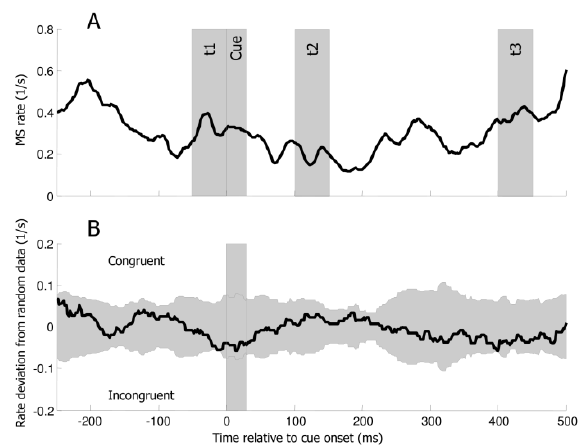
Figure 5. The modulation of microsaccade rates du fixation in an auditory non-predictive cue-target task. This figure was created using the same analysis as in Fig. 3.